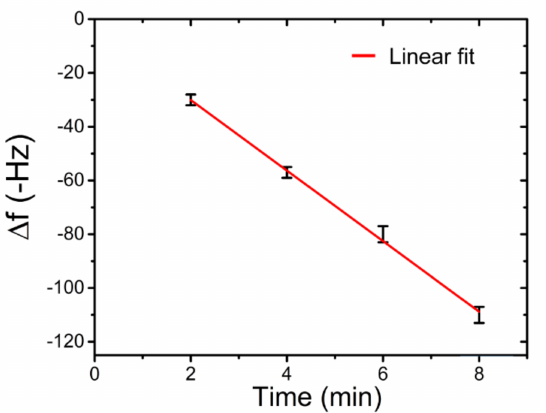
Figure 10. Frequency shift vs. exposition time at a mercury concentration of 400 µ g/m 3 ± 10 µ g/m 3